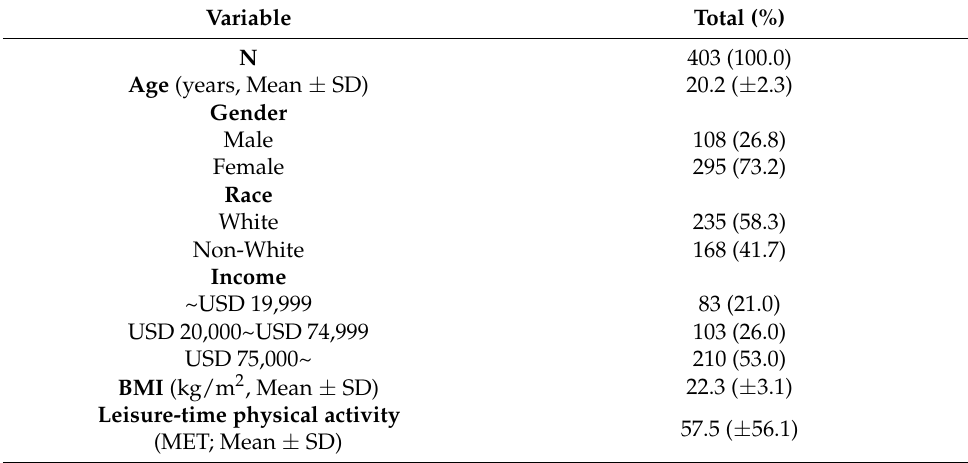
Table 1. Descriptive statistics of all female and male